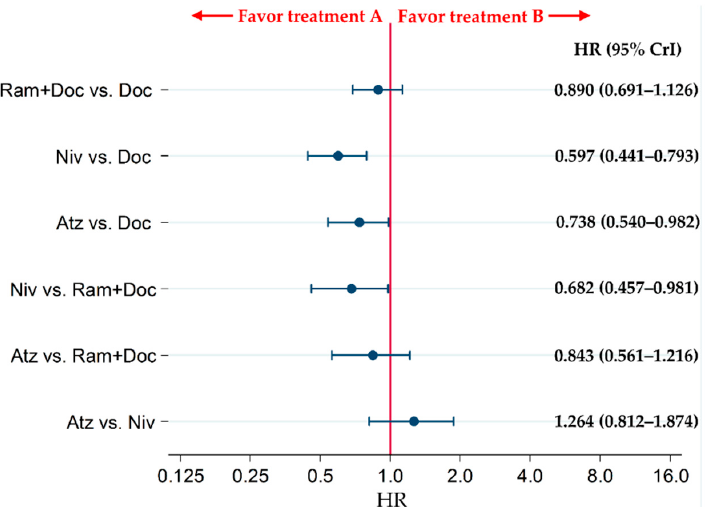
Figure 5. Comparative efficacy of the four therapeutic regimens, Ram+Doc, Doc, Niv and Atz, pertaining to the OS of patients with refractory or relapsed advanced squamous non-small-cell lung cancer. The patient inclusion criteria for all RCTs in this analysis did not place any limitations on PD-L1 status. Comparisons are represented as treatment A versus treatment B. Data are presented as HRs and 95% CrIs. Ram+Doc (ramucirumab plus docetaxel); Doc (docetaxel); Niv (nivolumab); Atz (atezolizumab); HR (hazard ratio); CrI (credible interval).